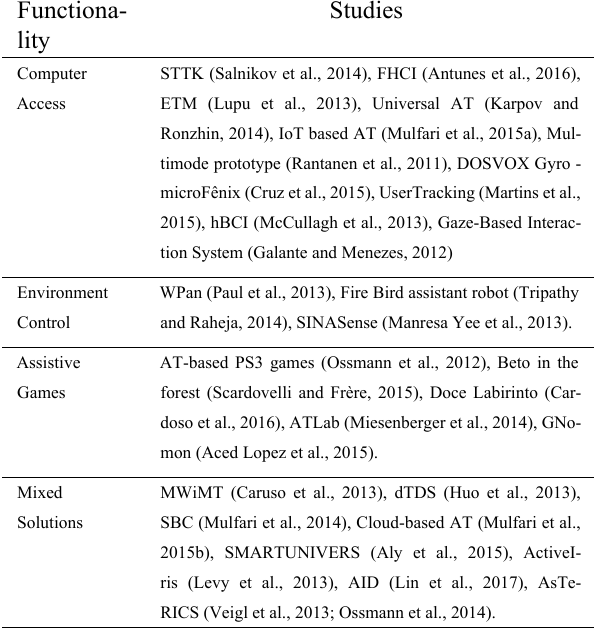
Tabela 1. Studies grouped according to functionalities.